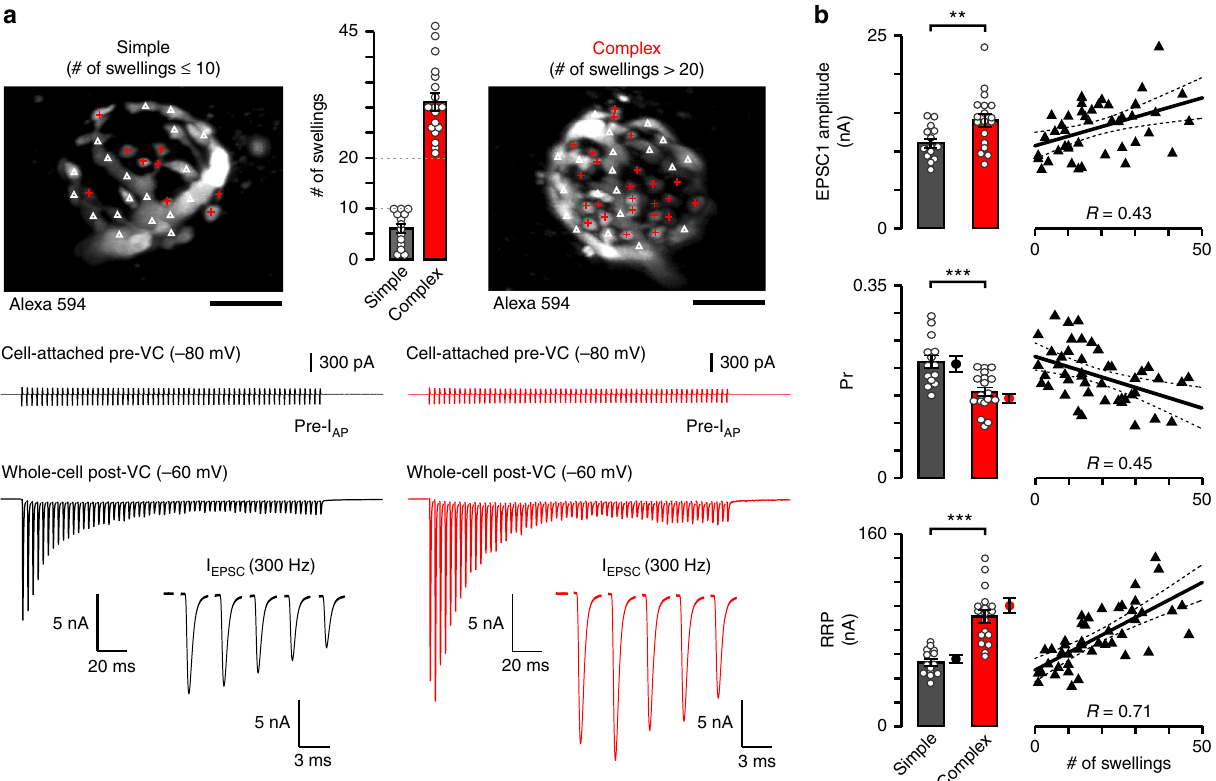
Fig. 1 Mature calyx of Held synapses with diverse morphologies exhibit distinct synaptic function. a Simple ( ≤ 10 swellings, black) and complex (>20 swellings, red) calyces are visualized in z -axis projection images (Alexa 594, 60 μ M; stalks, white arrowheads; swellings, red crosses). Bar graphs show the average number of swellings (simple, 6.1 ± 0.91, n = 14/11, complex, 31.1 ± 1.73, n = 18/16, t = 12.762, p < 0.0001, df = 25, unpaired t -test